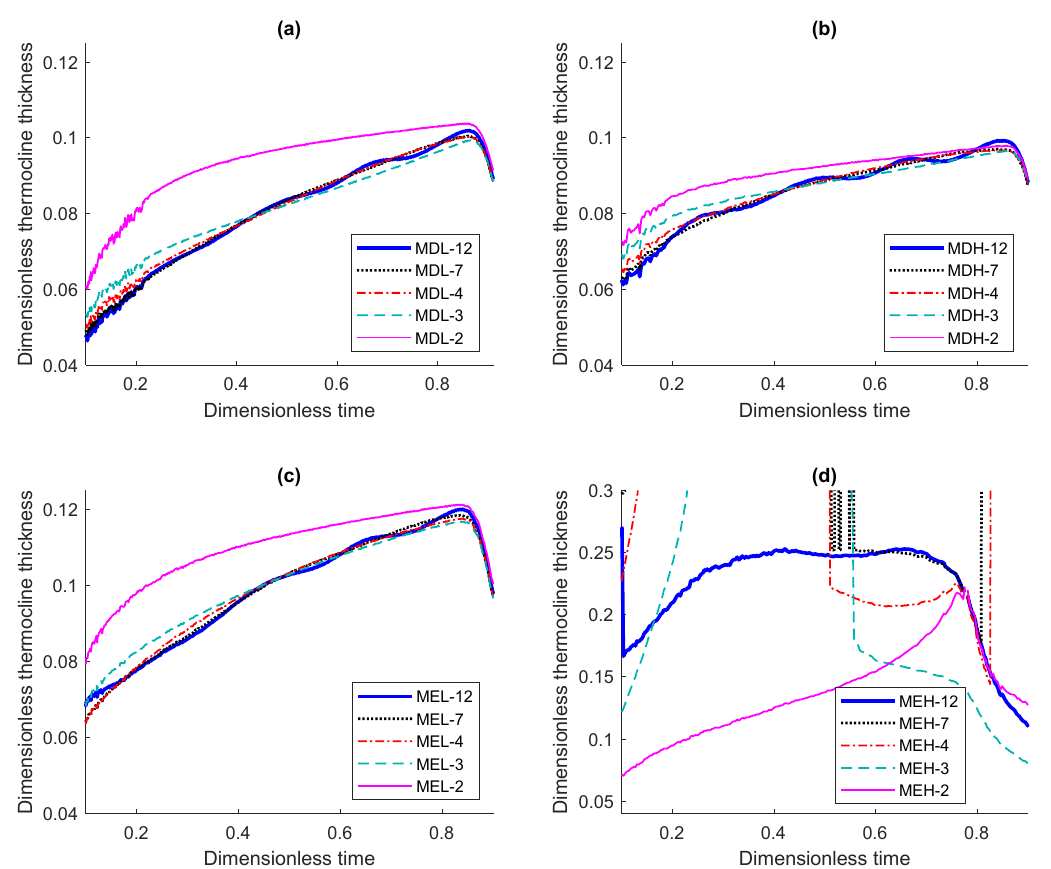
Figure 5. Evolution of the thermocline thickness at the points where the thermocouples were located. Estimation with MDL ( a ), MDH ( b ), MEL ( c ) and MEH ( d ) models.